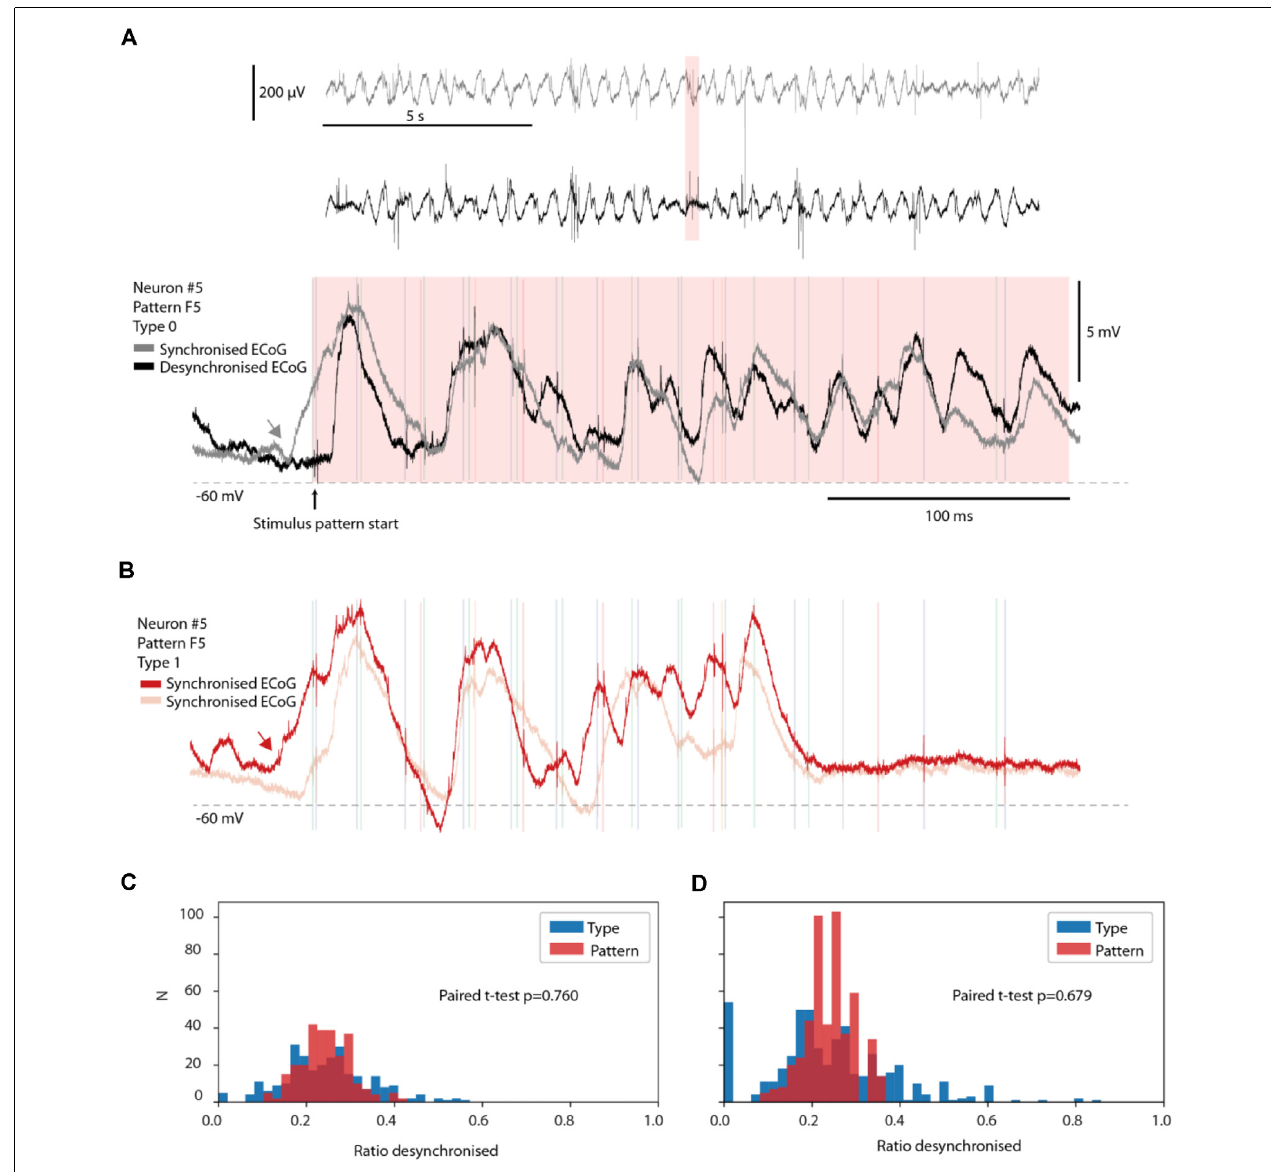
FIGURE 5 | No preferred ECoG state for specific response types. (A) Two sample responses belonging to the same response type evoked during synchronized and desynchronized ECoG states. Top two traces are time-compressed ECoG recordings. The pink time zone is expanded below to illustrate the corresponding intracellular responses of a recorded neuron, superimposed. Note the rising Upstate starting before the onset of the stimulation (gray arrow) for the gray trace (synchronized ECoG). (B) Two sample responses from the same neuron and stimulation pattern as in (A) , but from response Type 1. Both traces occurred during synchronized ECoG states. The red trace had a rising Upstate that started (red arrow) at almost the exact same time as in the gray trace in (A) . (C,D) The fraction of responses occurring in the desynchronized ECoG state for the responses evoked by each stimulation pattern is shown in red, for each neuron, and for each member of a response type (blue). The fraction for each response type is hence paired with the corresponding fraction for the stimulation pattern. The bar chart in (B) illustrates the results of this investigation only for response types with more than nine members (nine responses). In (D) , the same display but for all response types identified (including those with less than 10 members, N =